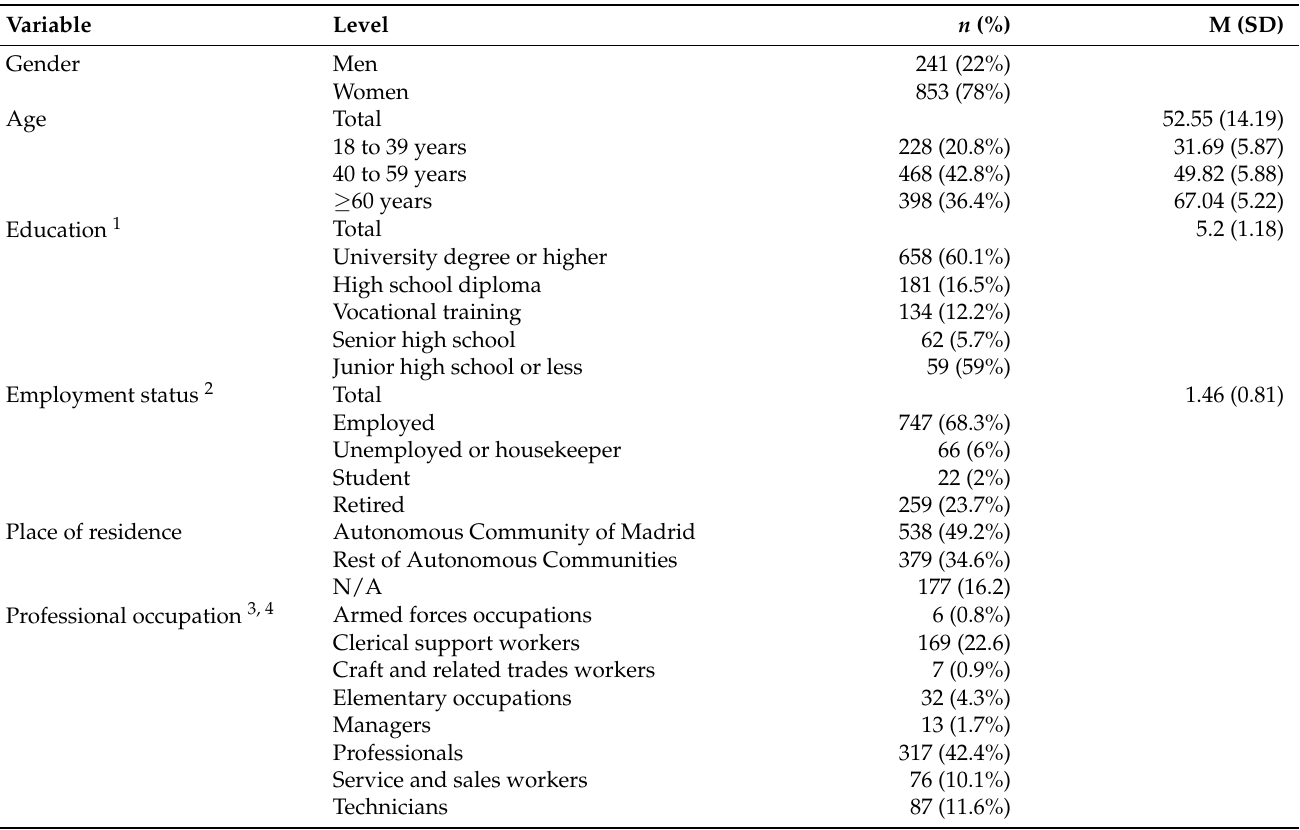
Table 1. Description of socio-demographic background variables. Percentages and SDs are shown in